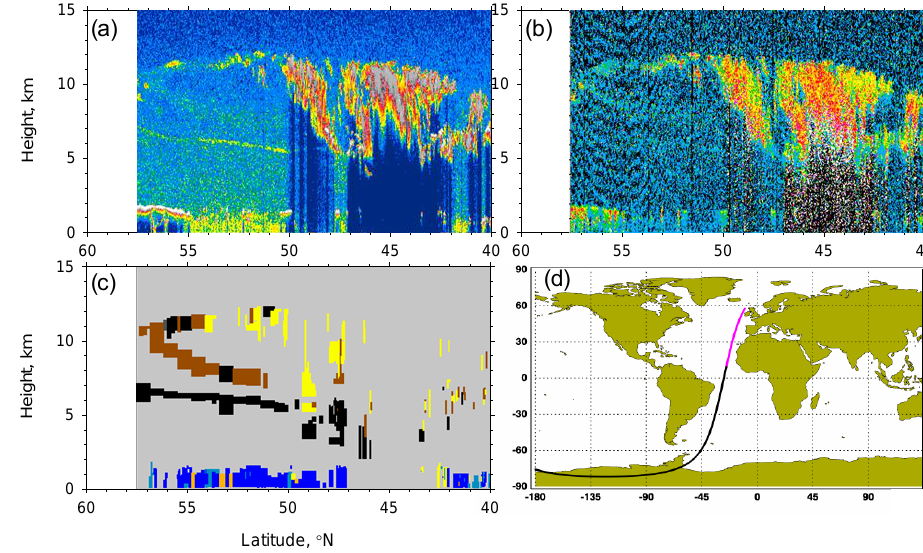
Figure 16. As Fig. 14 for a section of the CALIPSO orbit which passed over the Atlantic from 03:17 to 03:22UTC on 23 May